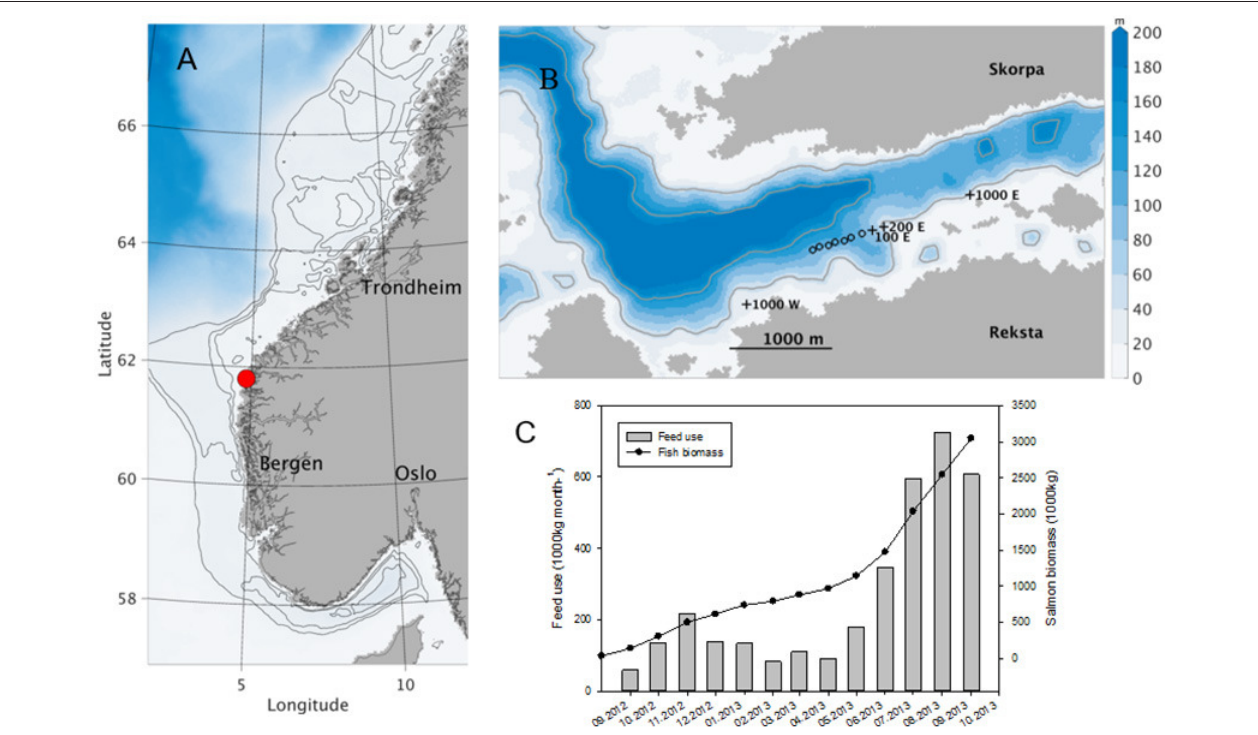
FIGURE 1 | (A) Large scale map showing the approximate position of the fish farm “Flåtegrunnen” at Rekstad, Sogn andFjordane. (B) Detail of the computational domain for the study area in 32m horisontal resolution showing the positions of the salmon cages and the four experimental stations situated 100m (100 E), 200m (200 E) and 1,000m East (1,000 E), and 1,000m West (1,000W). The colors indicate bottom depth, and the gray curves are 50 and 150m isobaths. (C) Monthly fish biomass and feed used from August 2012 to September